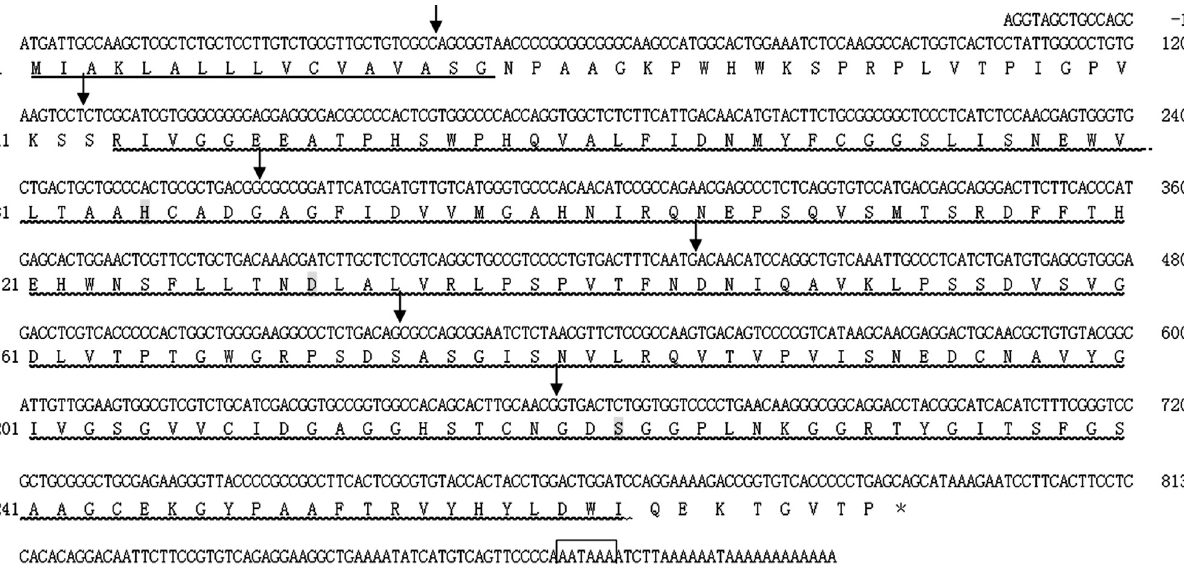
Figure 1 - Nucleotide and deduced amino acid sequences of the SpCHY gene (GenBank accession no. JF831535.1). The nucleotides are numbered on the right, and the amino acids on the left. The putative signal peptide is underlined. The trypsin-like SP domain is wave underlined. The catalytic triad (H, D, and S) is gray shadowed. The boxed letters are the polyadenylation signal. The asterisk (*) indicates the stop codon and arrows indicate the location of